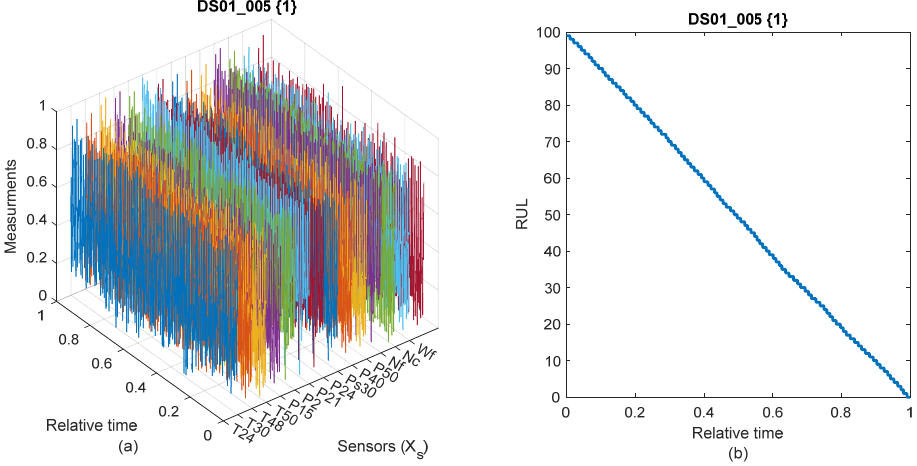
Figure 2. An overview of a degradation life path from N-CMAPSS dataset: ( a ) Sensors measurements behavior in a life path from N-CMAPSS; ( b ) RUL trend in a single lifecycle.